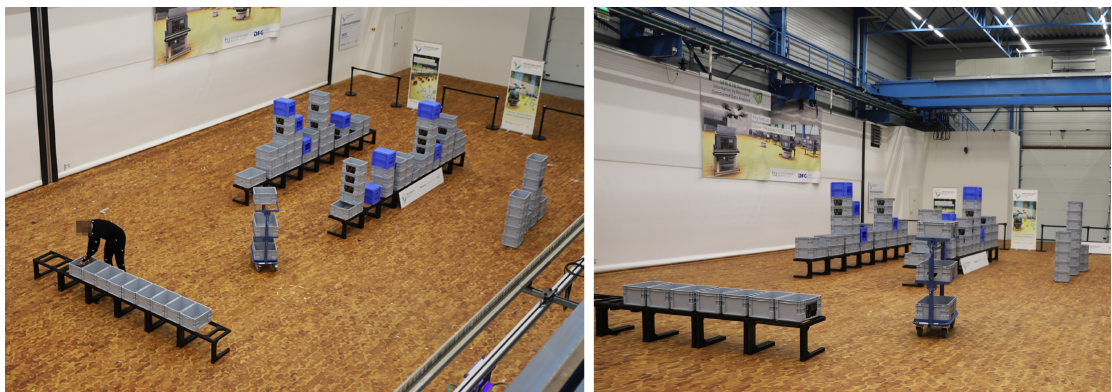
Figure 2. Physical laboratory set-up of logistics Scenario 1—simplified order